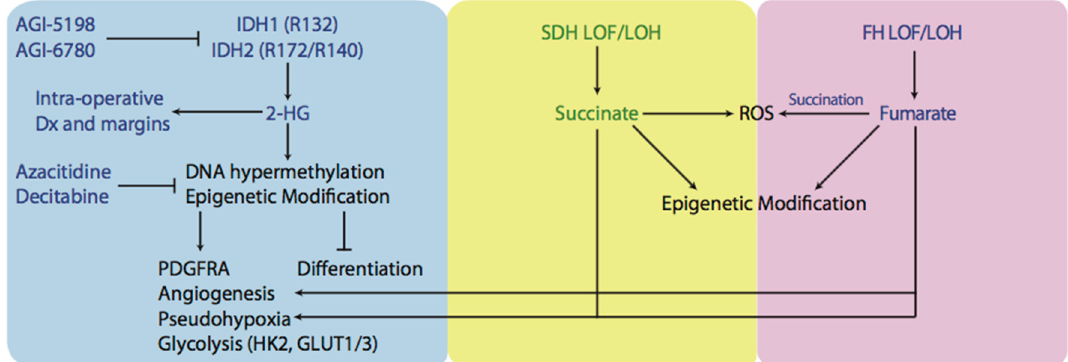
Figure 2. Schematic representation of an oncometabolic perspective of tumorigenesis. Mutated IDH1 and IDH2 produce oncometabolite known as 2-HG which goes on to exert several effects believed to trigger tumorigenesis. By inhibiting α KGDDs like cytosine hydroxylases, TET2, histone demethylases, IDH1/2 tumors exhibit CIMP phenotype as well as other epigenetic modifications and have inhibited differentiation. Tumours with high levels of 2-HG, succinate, or fumarate have been demonstarted to undergo a phenomenon known as pseudohypoxia and have increased levels angiogenesis. Furthermore, upregulation of HIF-1 α target genes like HK2 and GLUT1 and GLUT3 were found in tumours containing IDH1/2 mutations and were associated with increased rates of glycolysis. Another potential cause of tumorigenesis is the production of ROS and tumours with SDH or FH LOF or LOH have been demonstrated to have high levels of ROS. Small molecular inhibitors have been designed to target IDH1/2 mutants (AGI-5198, AGI-6780) or reverse hypermethylation levels/CIMP phenotype (azacitidine, decitabine). Furthermore, 2-HG can be detected interaoperatively during tumour resection and be used as an indication of tumor margins. IDH: isocitrate dehydrogenase; 2-HG: 2-hydroxyglutarate; α KGDD: α -Ketoglutarate-dependent dioxygenases; TET2: Tet